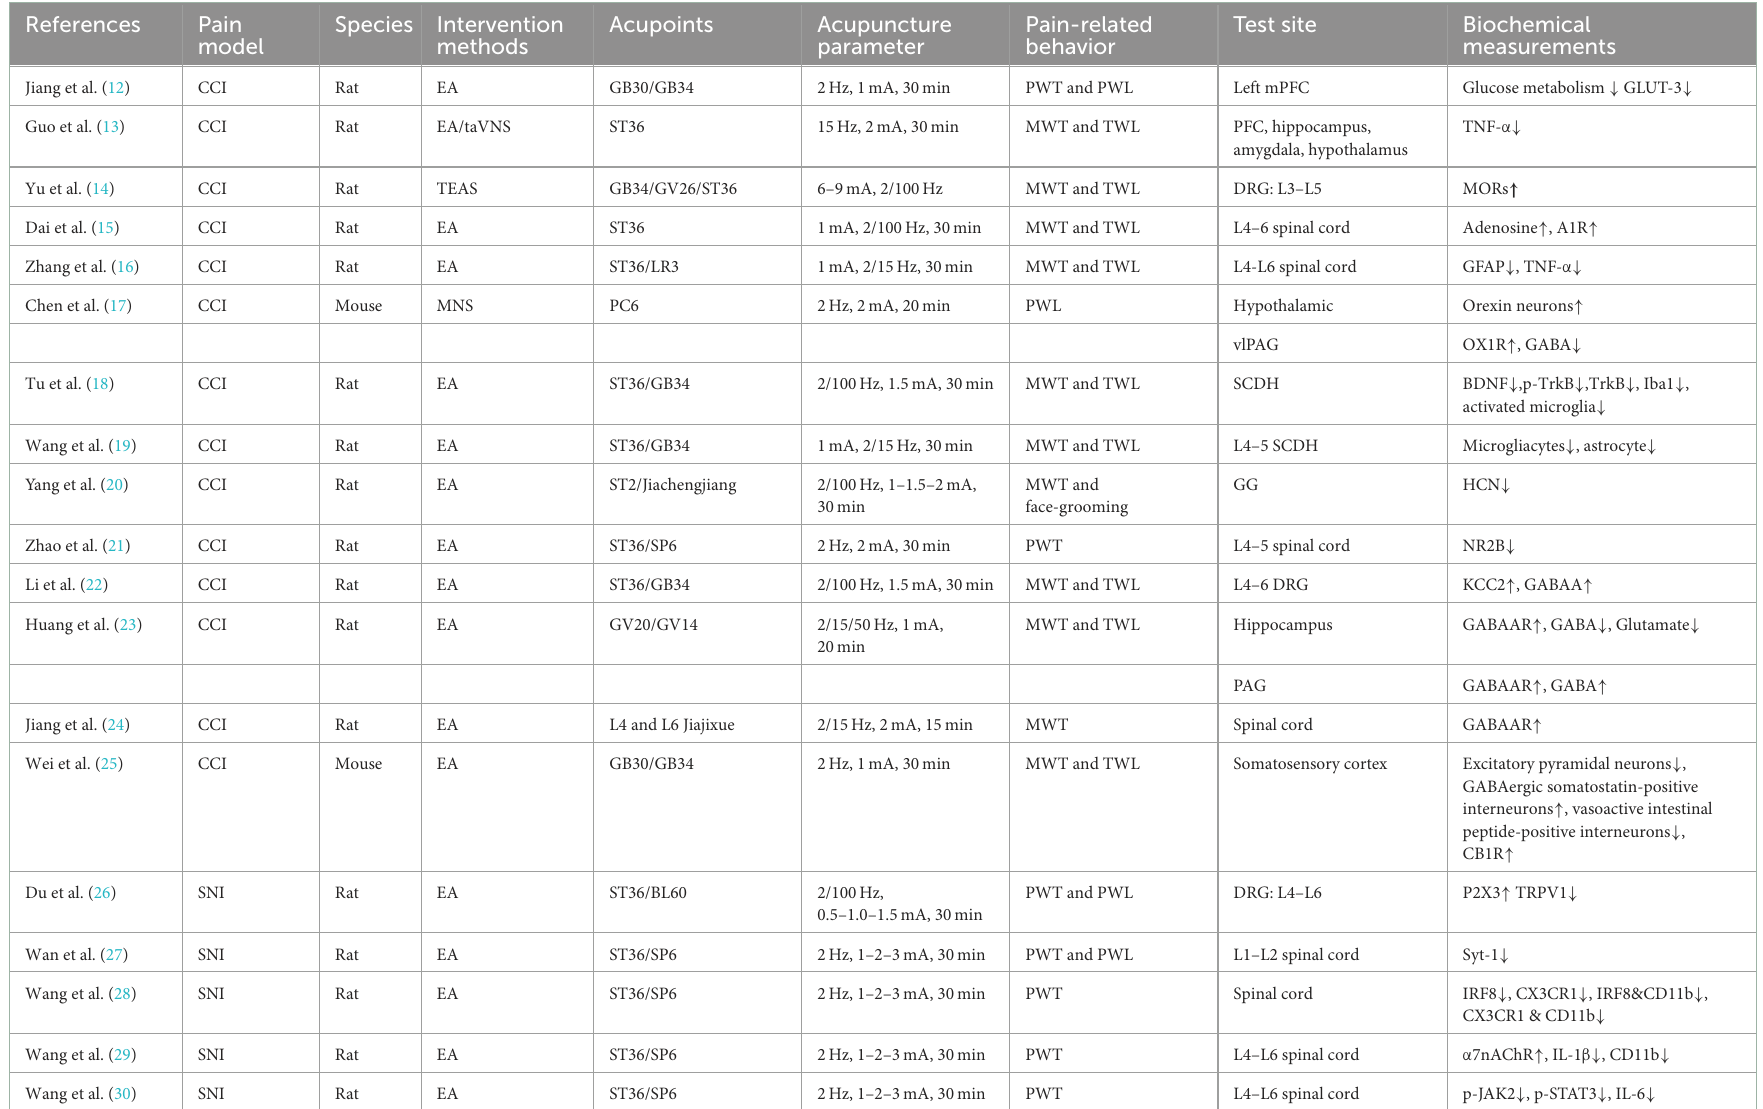
TABLE 1 Modulation of analgesic effect of acupuncture on neurogenic